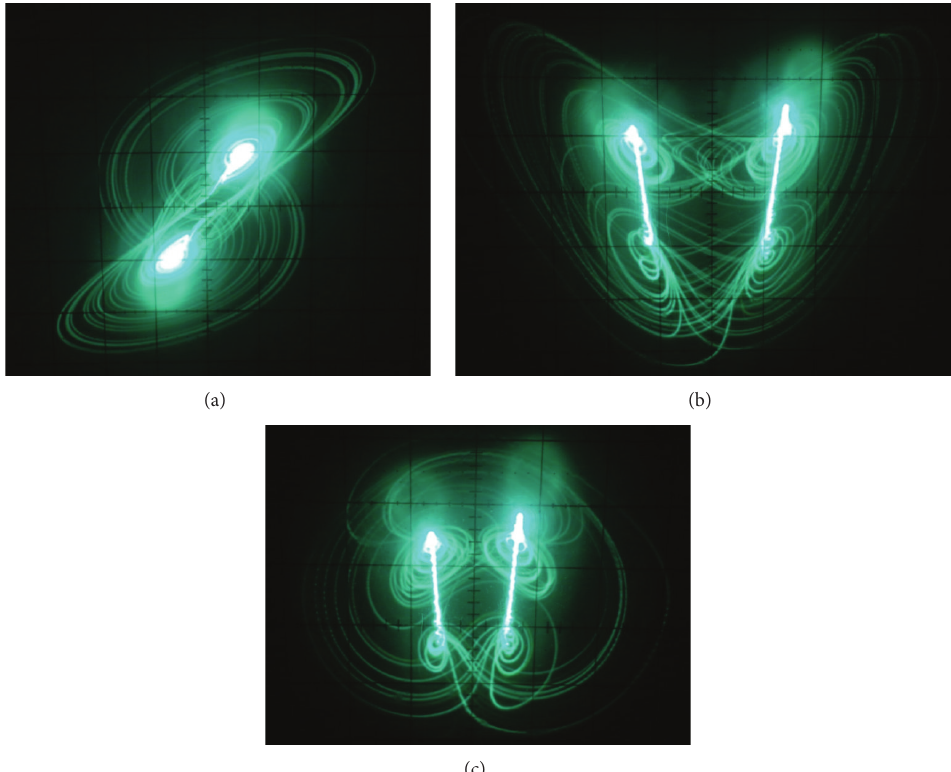
Figure 10: Chaotic motion shown in the phase portraits of the system (6) with 𝐴 = 0.8 V and 𝑓 = 385 Hz: (a) 𝑥 - 𝑦 plane; (b) 𝑥 - 𝑧 plane; (c) 𝑦 - 𝑧 plane.